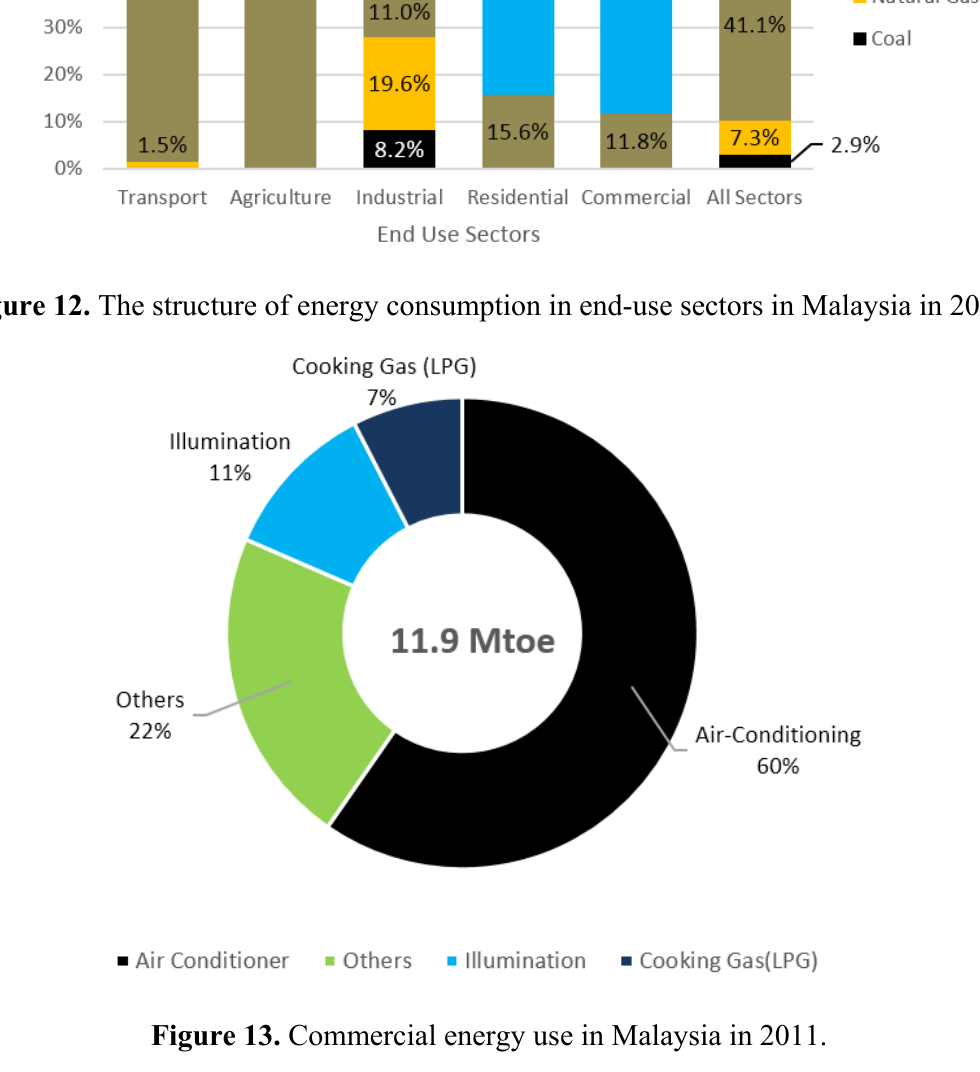
Figure 13. Commercial energy use in Malaysia in